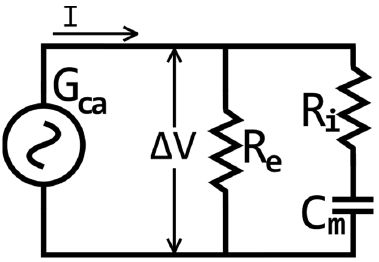
Fig.1: Analogous electrical model which equates biological tissue components to passive electrical elements. R e is a resistor which mimics extra-cellular fluids together with some connective tissue elements and is parallel to R i which mimics resistance of intracellular fluids and is serially connected to the capacitor C m representing electrical charges separated by the cell